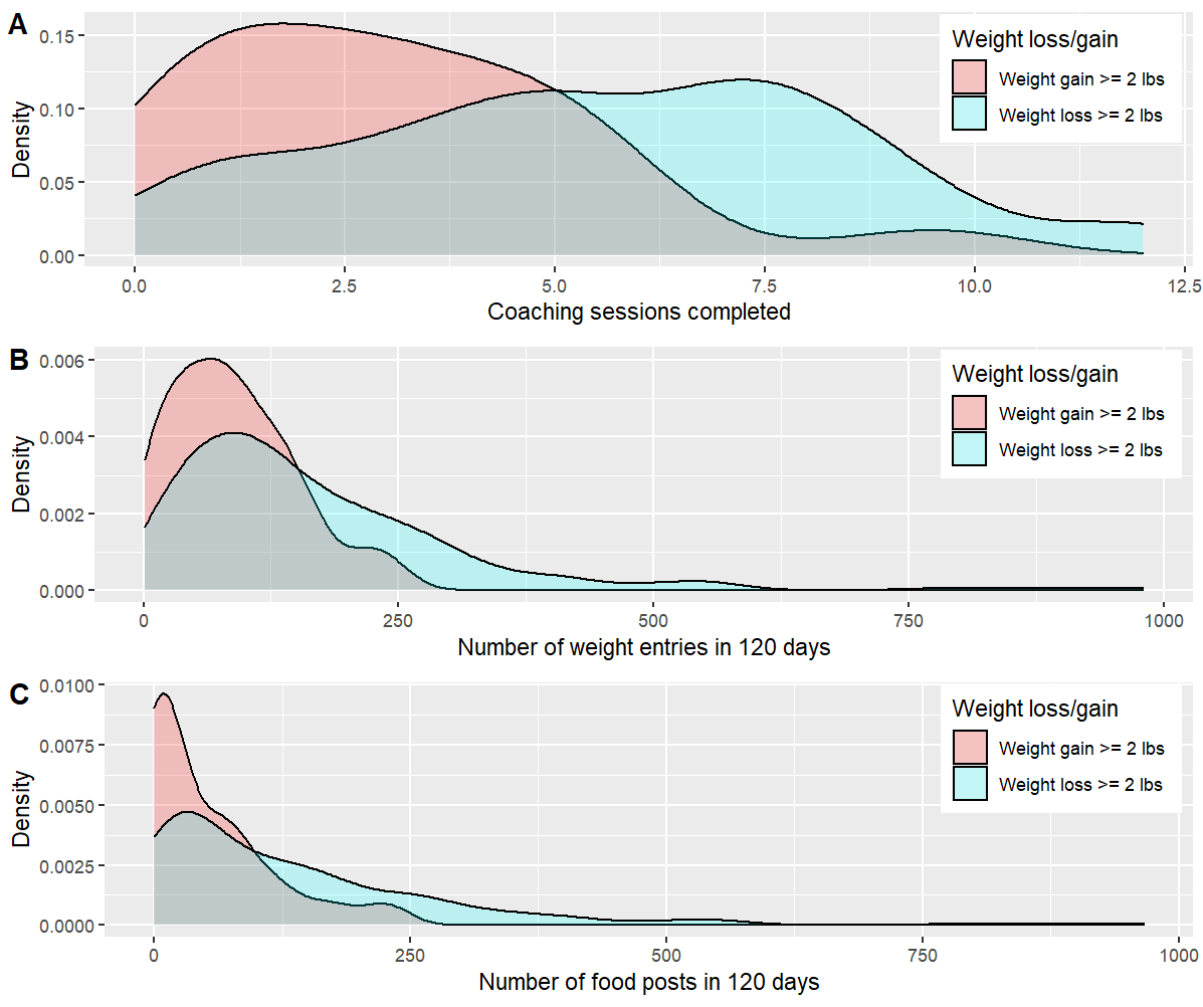
Figure 6. Distributions of engagement variables differ by weight loss group. Measures of engagement were higher in participants who lost weight (blue) versus those who gained weight (red). Statistical difference in means confirmed by the Welch two-sample t test (A) coaching sessions ( P <.001), (B) number of weight entries ( P <.001), and (C) number of food posts ( P <.001). Less than 2-lb gain or loss was considered negligible and excluded from this figure. Engagement variables were summed over the study period of 120